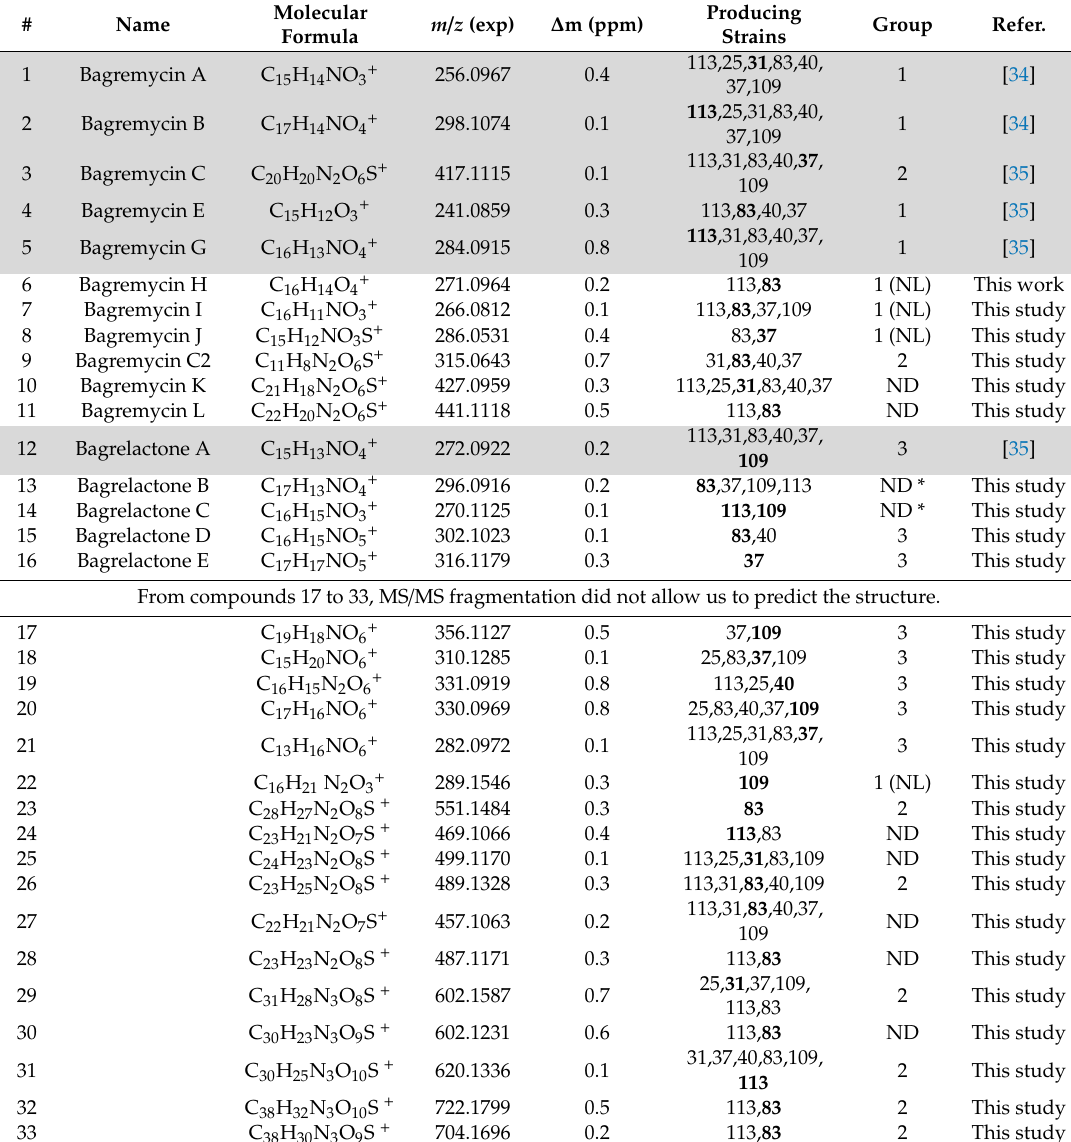
Table 1. Bagremycin- and bagrelactone-related compounds produced by the different S. lunaelactis